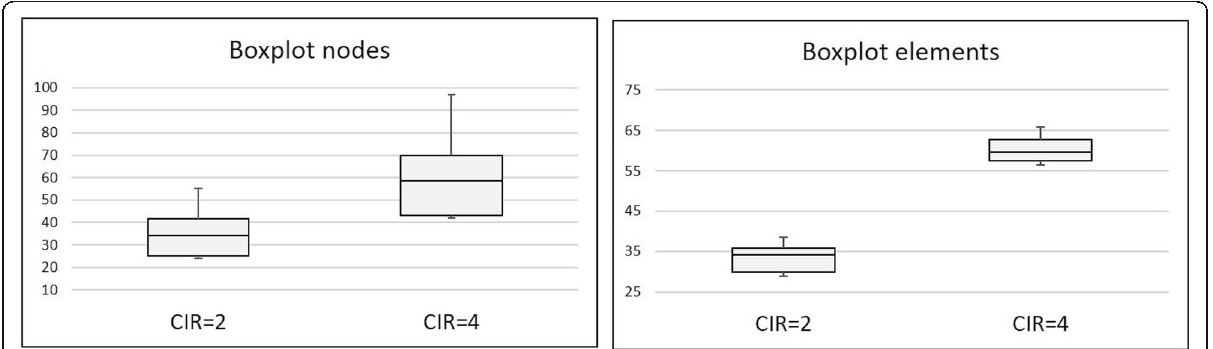
Fig. 9 Comparison between the central tendencies of the reference model and the CIR = 2 model, putting in evidence the significant differences